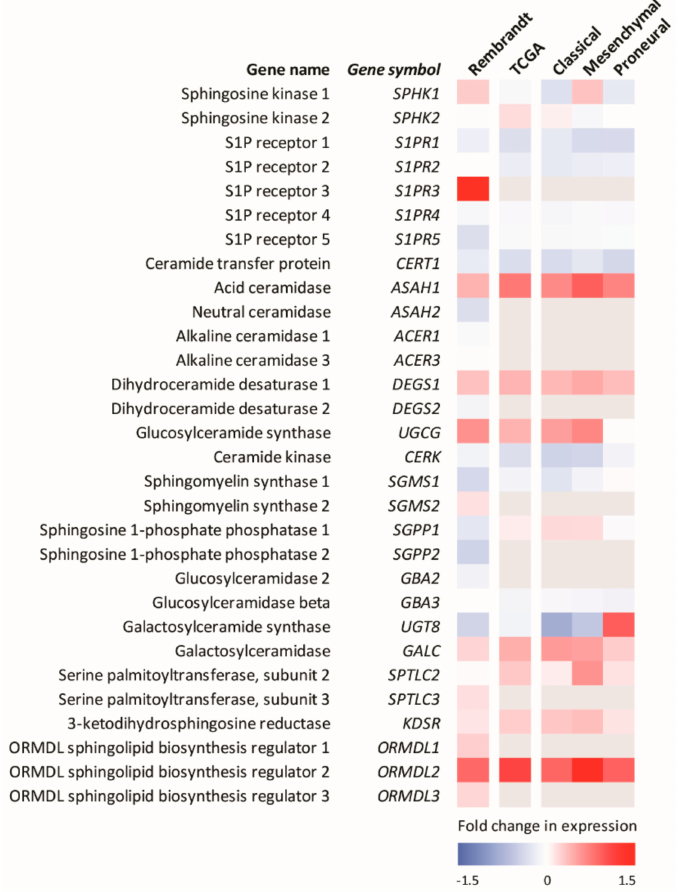
Figure 3. Analysis of mRNA levels of sphingolipid metabolic enzymes in GBM patients from publicly available Rembrandt and Cancer Genome Atlas brain cancer datasets show small but significant di ff erencesingeneexpressioncomparedtothenormalbrain. Rembrandtdataset(n = 214). TCGAdataset (n = 169), which can be subdivided into Classical (n = 54), Mesenchymal (n = 58) and Proneural (n = 57) molecular subtypes. White boxes indicate genes which are not significantly di ff erentially expressed ( p > 0.05). Grey boxes indicate genes for which complete data were not available. Other genes involved in sphingolipid metabolism for which no data were available were: Ceramide synthases 1-6 ( CERS1-6 ), Alkaline ceramidase 2 ( ACER2 ), Acid sphingomyelinase ( SPMD1 ), Neutral sphingomyelinases 1 and 2 ( SPMD2 and SPMD3 ), Lipid phosphate phosphatases 1-3 ( PLPP1-3 ), and Serine palmitoyltransferase, subunit 1 ( SPTLC1